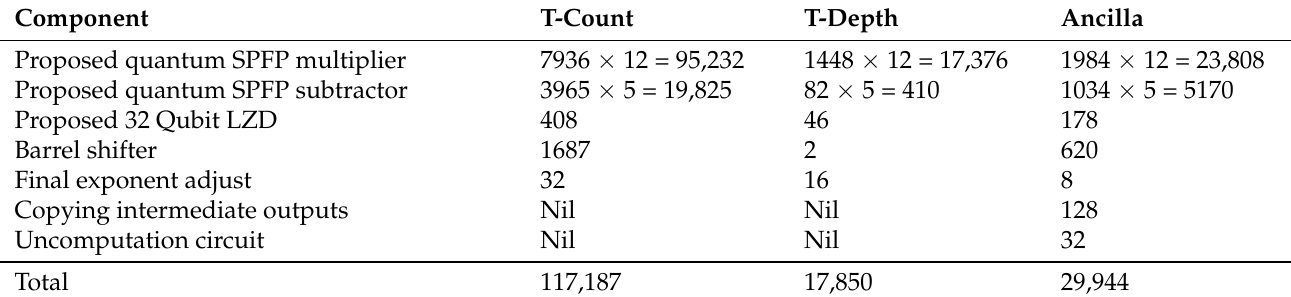
Table 4. Resource utilization of the proposed SPFP division circuit using Goldschmidt division algorithm.